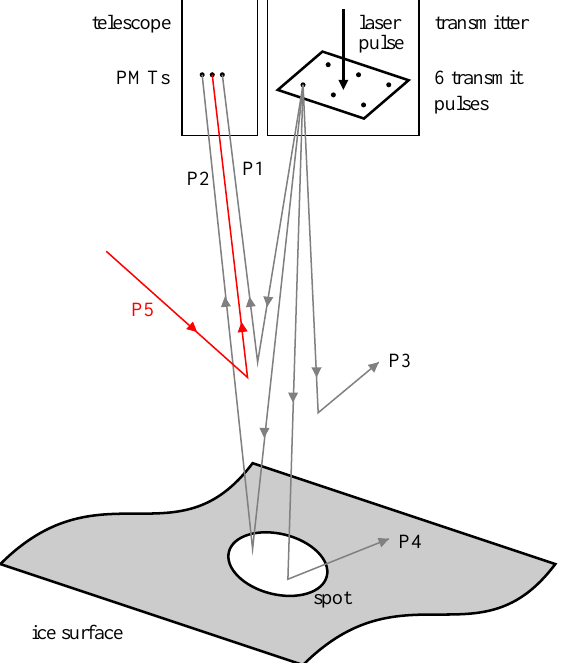
Figure 1: Sketch of single photon counting system of ATLAS. The original laser beam is split into six transmit beams and sent simultaneously to the ground where they illuminate a spot.